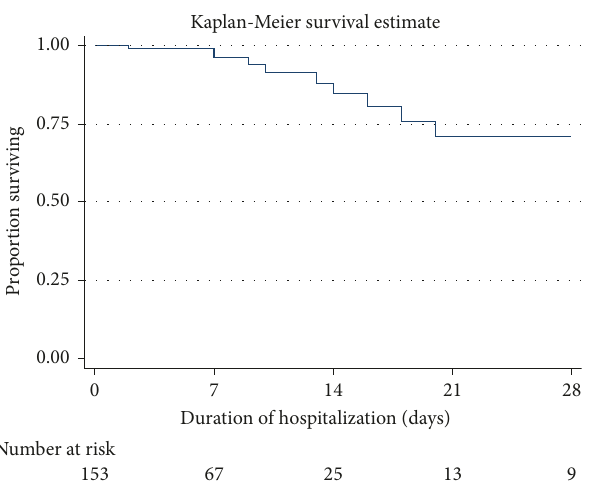
Figure 6: Survival among the